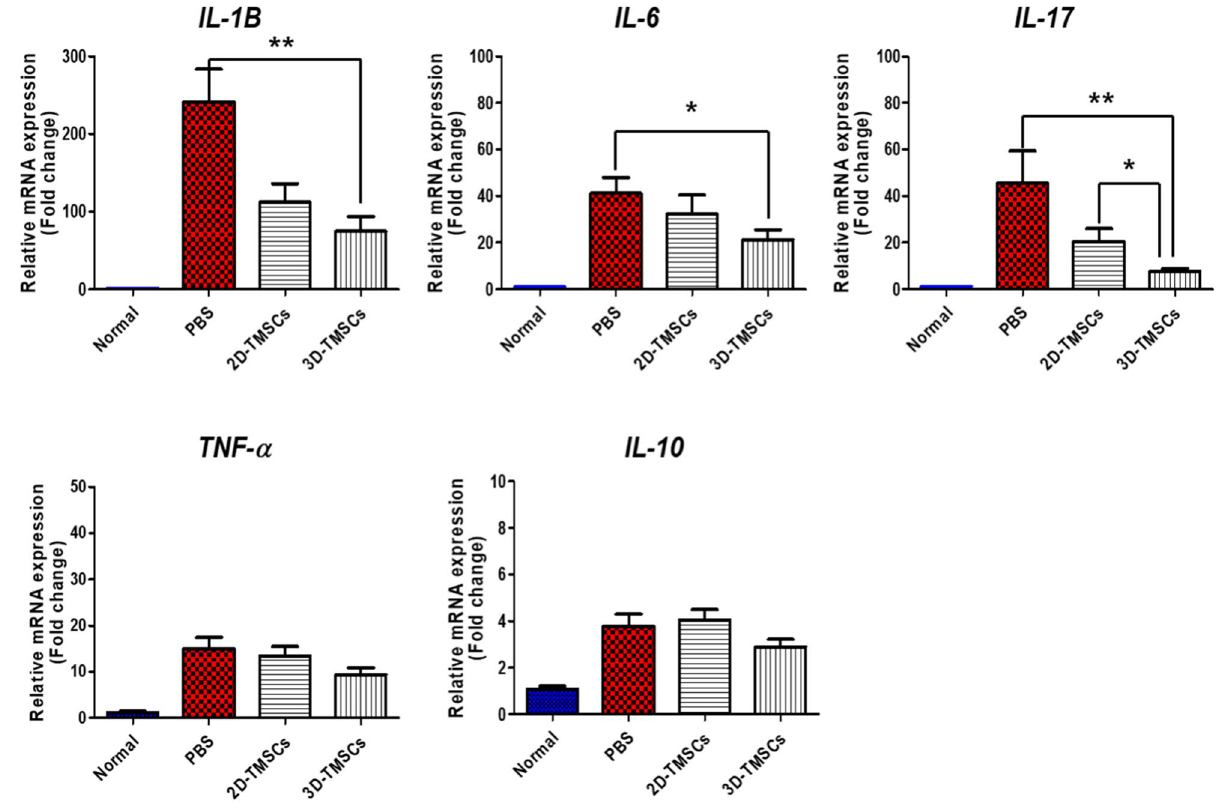
Figure 6. mRNA expression of cytokines in colon tissue treated with 3D-TMSC-treated groups. IL‑1β, IL‑6, and IL‑17 levels were significantly lower in the 3D-TMSC-treated group compared with the colitis control group. *P < 0.05, **P < 0.005. 3D, three-dimensional; TMSCs, tonsil-derived mesenchymal stem cells; IL, interleukin; PBS, phosphate-buffered saline; TNF-α, tumor necrosis factor